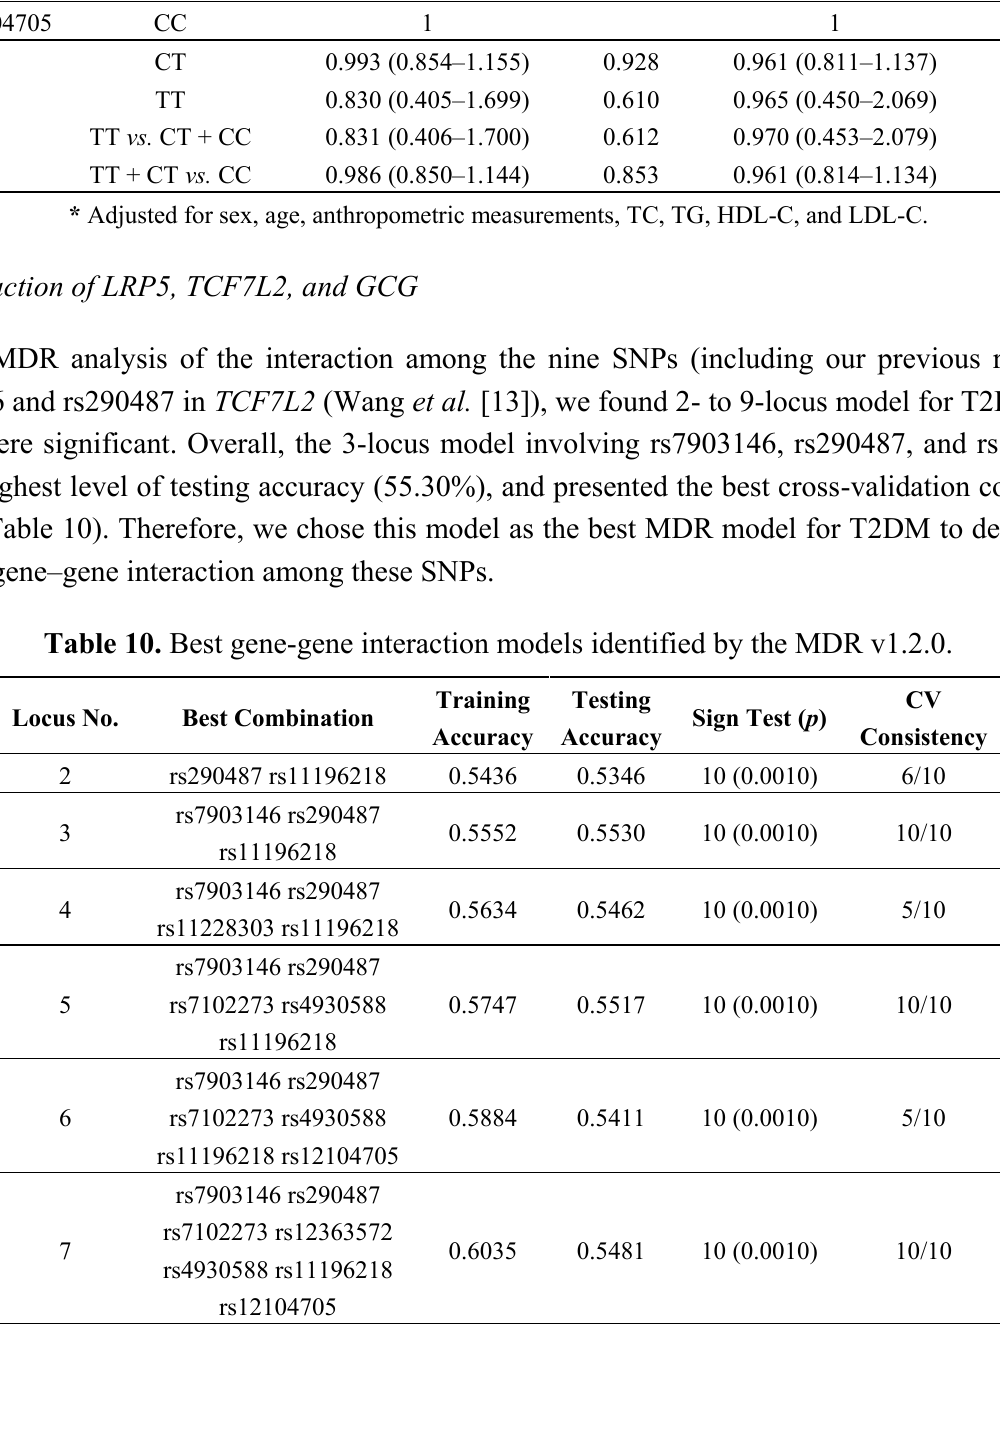
Table 9. Association of rs12104705 in GCG gene and T2DM in Han Chinese. SNPs